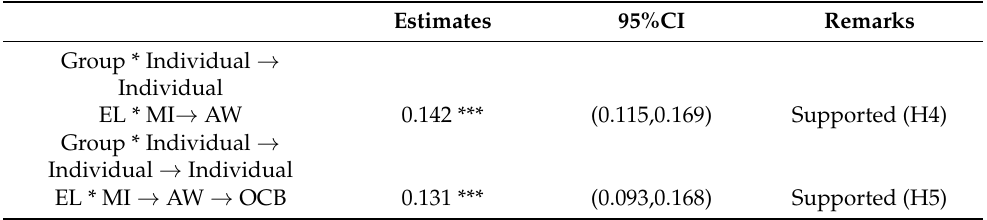
Table 5. Summary of moderation effects.